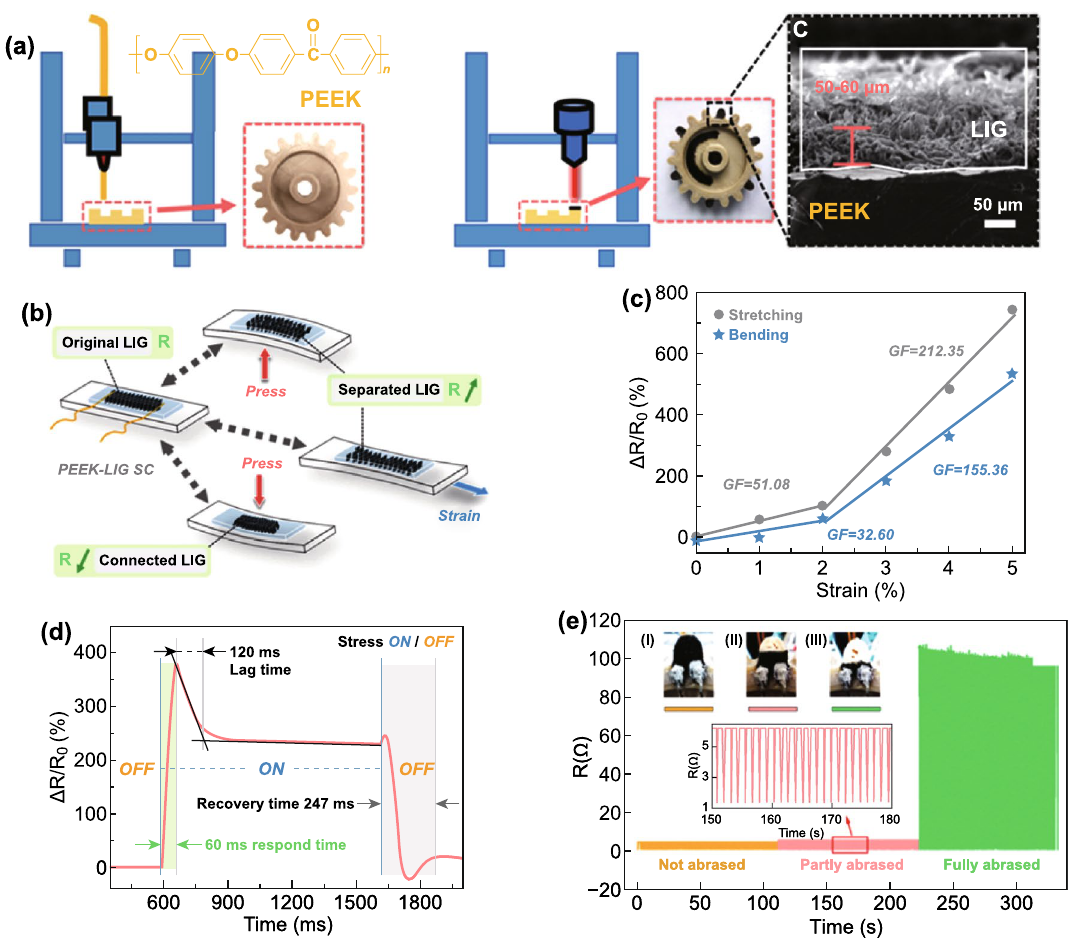
Fig. 7 a Schematic of the 3D printing of the PEEK component and the synthesis process of LIG from the 3D printed PEEK gear. b Working mechanism of PEEK–LIG SC for bidirectional bending and stretching. c Relative change in resistance of the sensor versus the applied strains. (The data were obtained after more than 1000 unloading cycles for the bending and stretching.) d Respond time and recovery time for bending (0–5% strain). e Circuit resistance increases because of abrading of the gear. The inset photographs showed three different abrasion degrees of the smart gear. (I) Not abrased, (II) partly abrased, and (III) fully abrased. a – e Adapted with the permission from Ref. [71], Copyright 2019 American Chemical